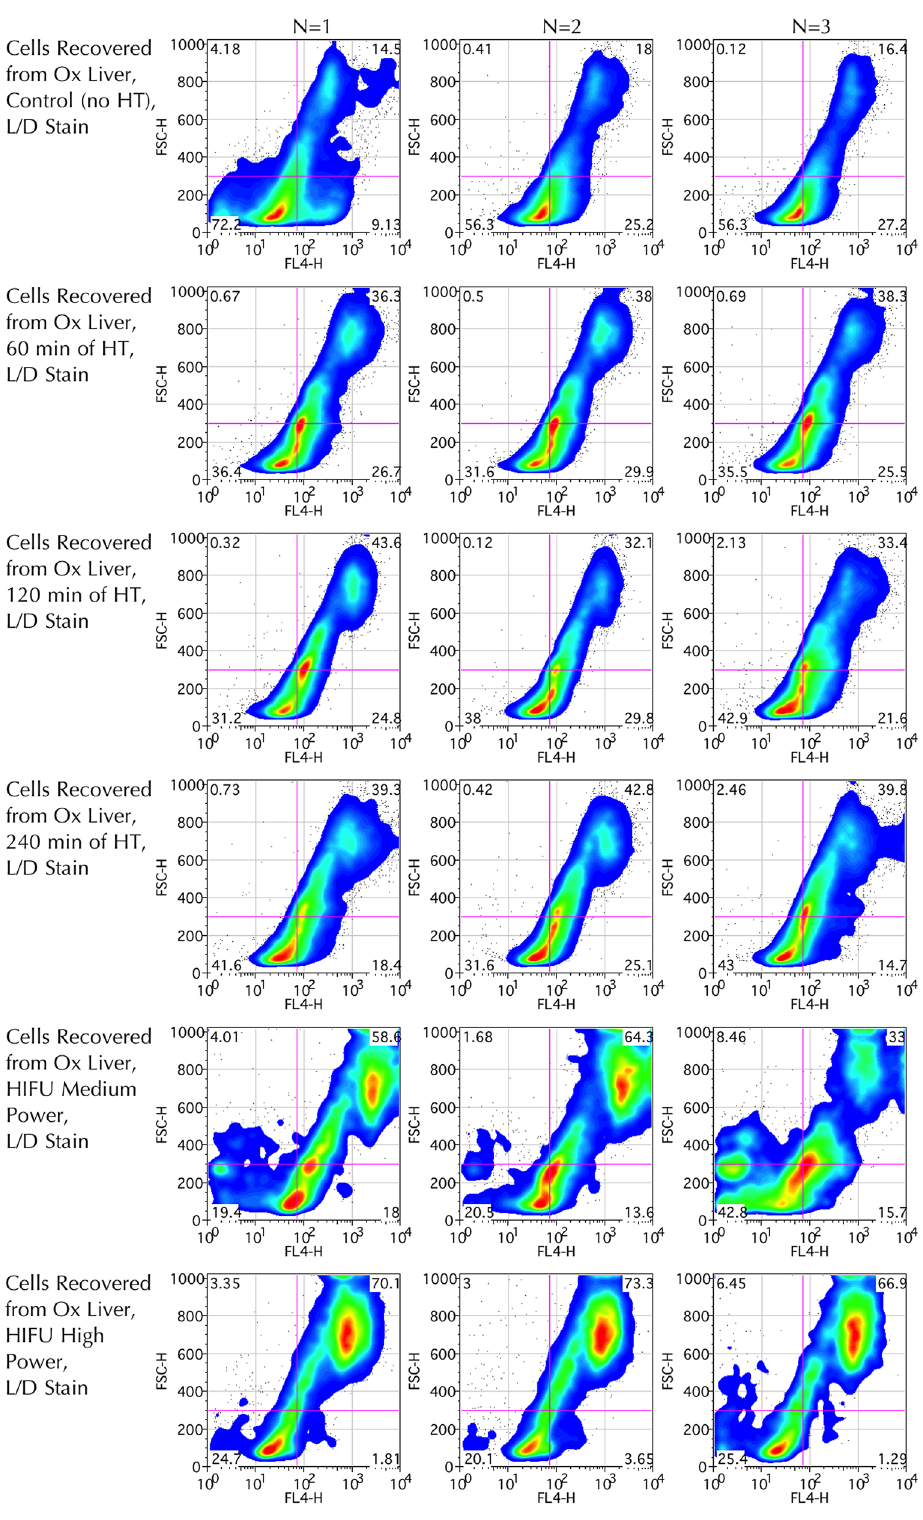
Figure 6. Cell viability flow cytometric studies of cells recovered from control liver and liver exposed to varying durations of hyperthermia and powers of HIFU. Each condition was performed in triplicate, i.e. three bags with liver sample exposed to hyperthermia and three liver lesions were performed and sampled individually at each HIFU power (N = 3, Columns). Representative plots for 0, 60, 120 and 240 min of hyperthermia (rows 1–4) and medium (7.27 MPa) and high (8.19 MPa) HIFU powers (rows 5–6) shown using FSC vs. far-red FL-4 channel (633/660 ± 16 nm). Events with FSC < 70 and/or FL-4 < 300 discarded, presumed to represent cell debris and/or impurities. Viability assessed using L/D stain. Trend for increased L/D staining intensity with samples receiving increasing insults, most markedly in the high power HIFU group, compared to the control group. Plots generated using FlowJo Data Analysis